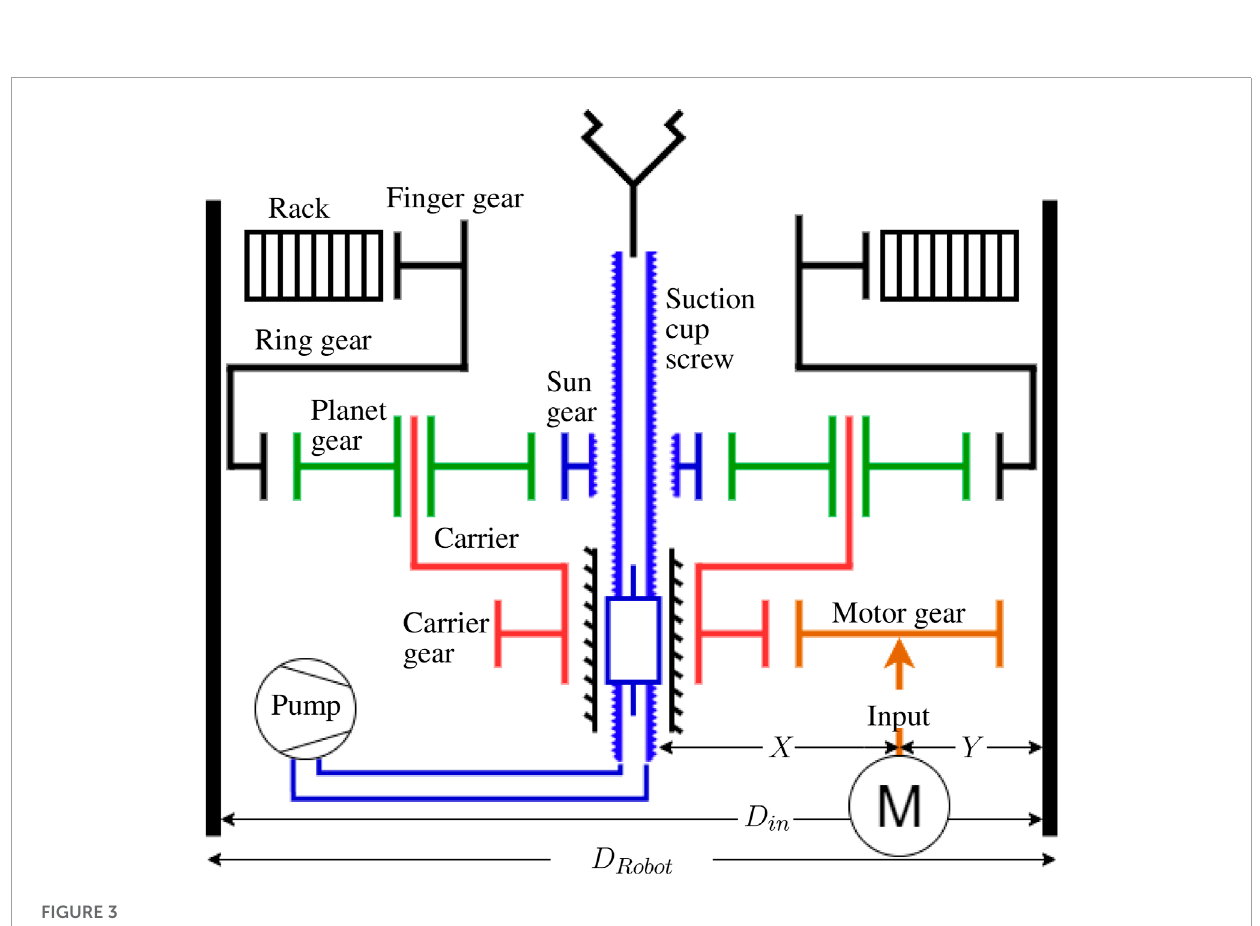
FIGURE 3 Transmission